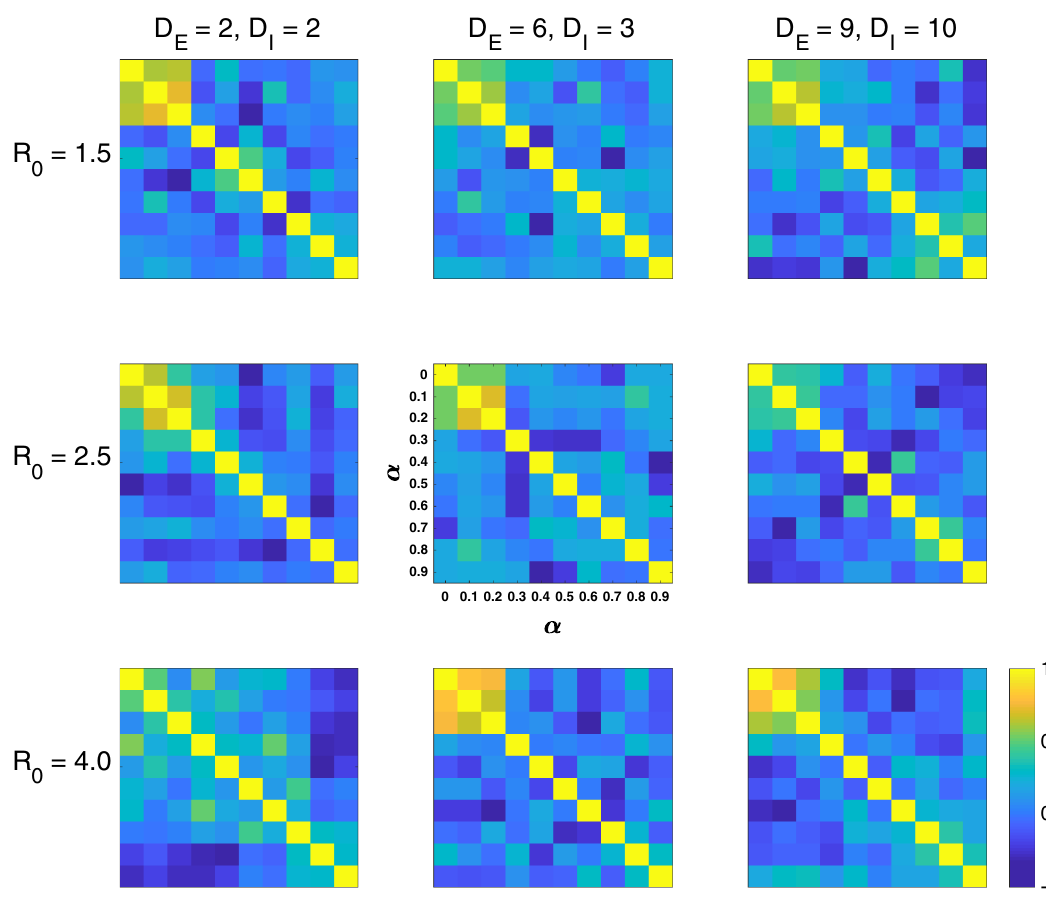
Figure 3. Spearman’s correlation of hazard rankings (top 30 entries in the rank) at different α (each sub- figure), for different sets of epidemiological parameters: R 0 = 1.5 / 2.5 / 4 (top to bottom) and infection duration ( D E , D I ) = ( 2, 2 )/( 6, 3 )/( 9, 10 ) days (left to right). Base case scenario (center) is R 0 = 2.5 and ( D E , D I ) = ( 6, 3 ) .